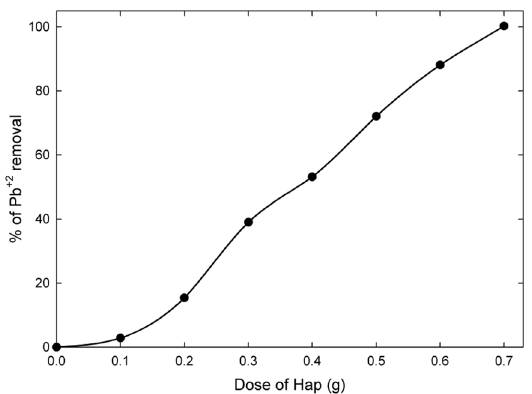
Figure 3. Effect of adsorbent dose on the removal of lead ions by